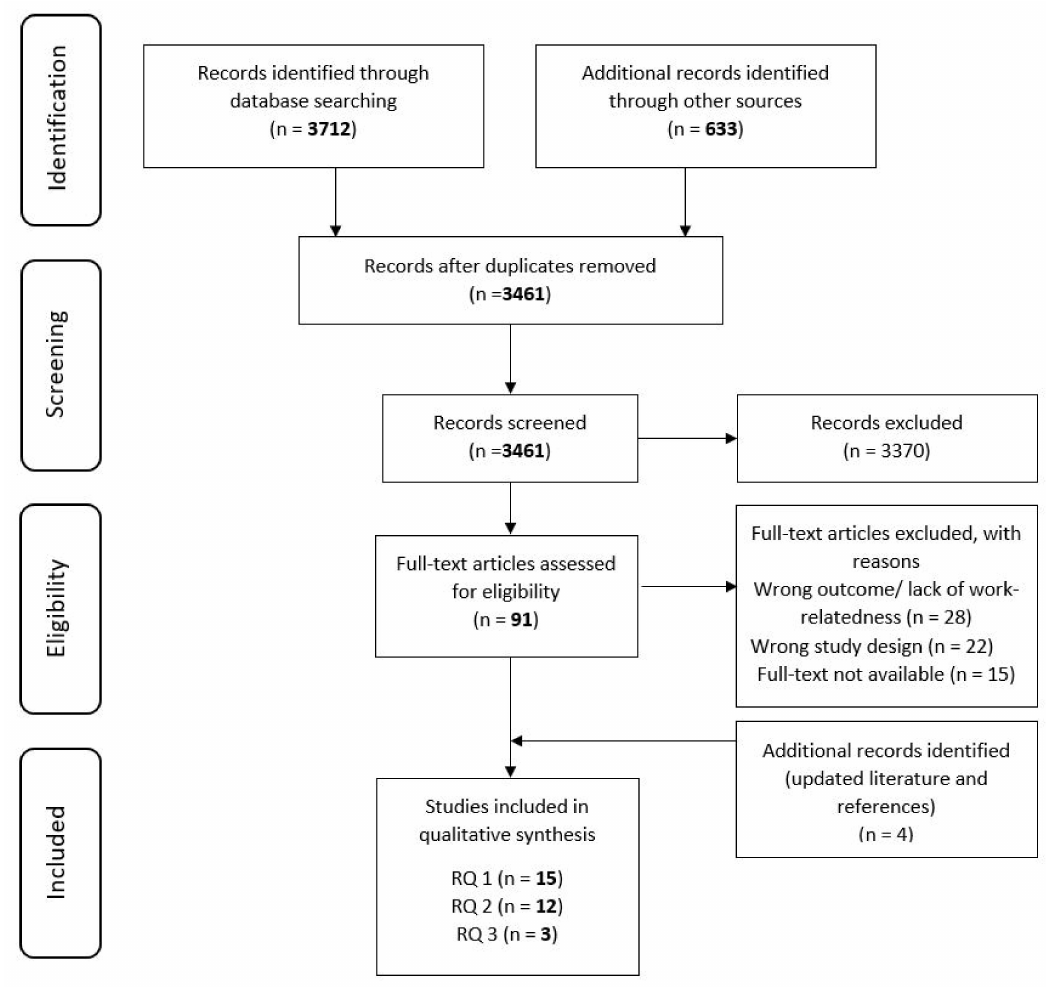
Figure 1. PRISMA flow chart for the study selection process [43].